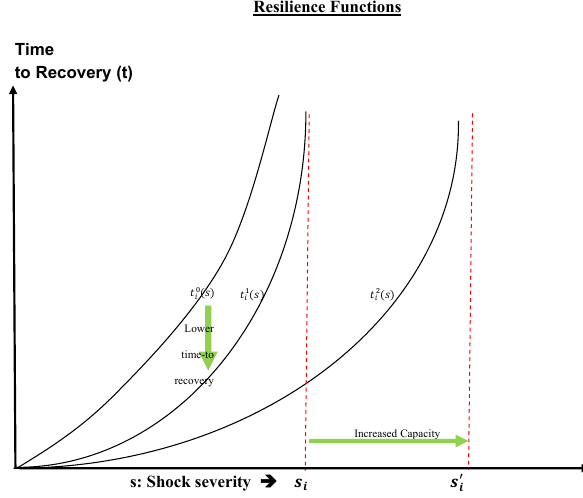
Figure 1. Three examples of resilience functions are show; time to recovery is a function of shock severity and of capacity. In relation to the reference function t 0 (s) , t 1 (s) shows the same capacity to withstand a shock up to severity level s i , but t 1 (s) exhibits greater recovery speed since, for any s < s i , we have that t 1 (s) < t 0 (s) . The third function t 2 (s) shows an increase in capacity. Shocks in the range s i < s < s (cid:48) have a finite recovery i